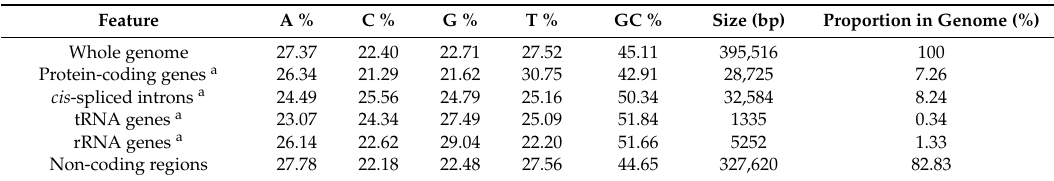
Table 1. Genomic features of P. vulgaris